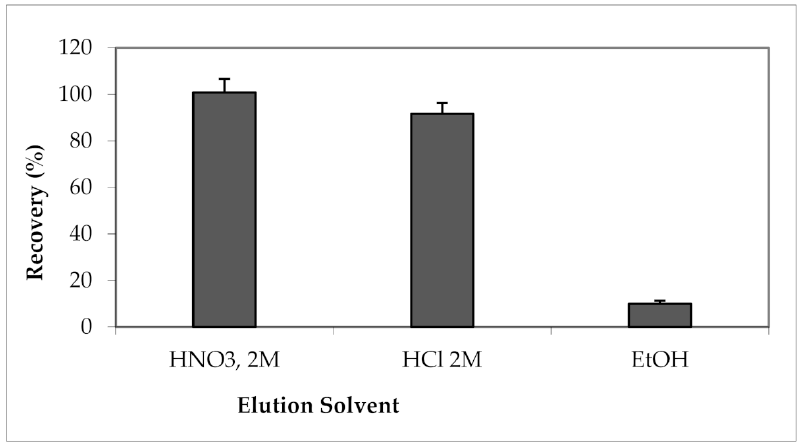
Figure 4. Effect of the elution solvent type on the extraction yield of Cu (II). Solvent volume = 10 mL.